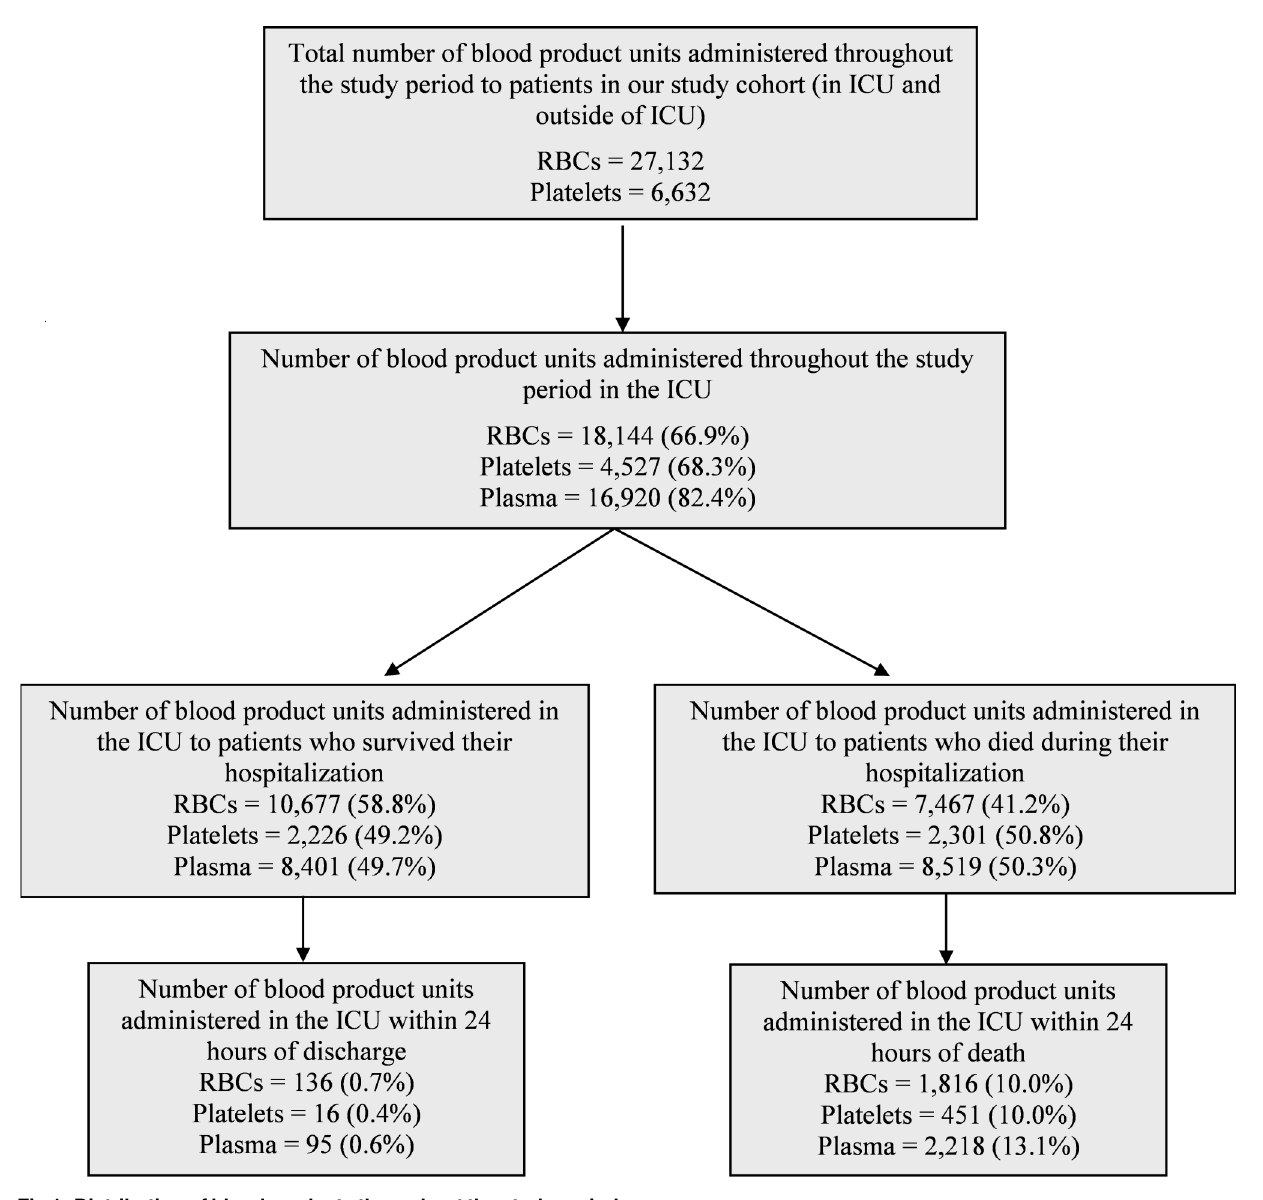
Fig 1. Distribution of blood products throughout the study